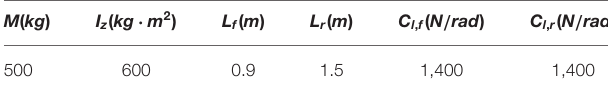
TABLE 1 | Parameters of the ego